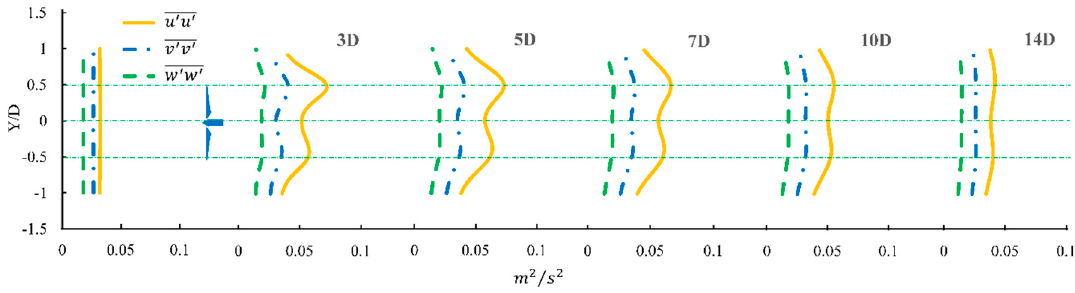
Figure 17. Horizontal distribution of (cid:1873) (cid:4593) (cid:1873) (cid:4593) (cid:3364)(cid:3364)(cid:3364)(cid:3364)(cid:3364)(cid:3364) , (cid:1874) (cid:4593) (cid:1874) (cid:4593) (cid:3364)(cid:3364)(cid:3364)(cid:3364)(cid:3364)(cid:3364) and (cid:1875) (cid:4593) (cid:1875) (cid:4593) (cid:3364)(cid:3364)(cid:3364)(cid:3364)(cid:3364)(cid:3364)(cid:3364) simulated by RSM. Figure 17. Horizontal distribution of u (cid:48) u (cid:48) , v (cid:48) v (cid:48) and w (cid:48) w (cid:48) simulated by RSM.